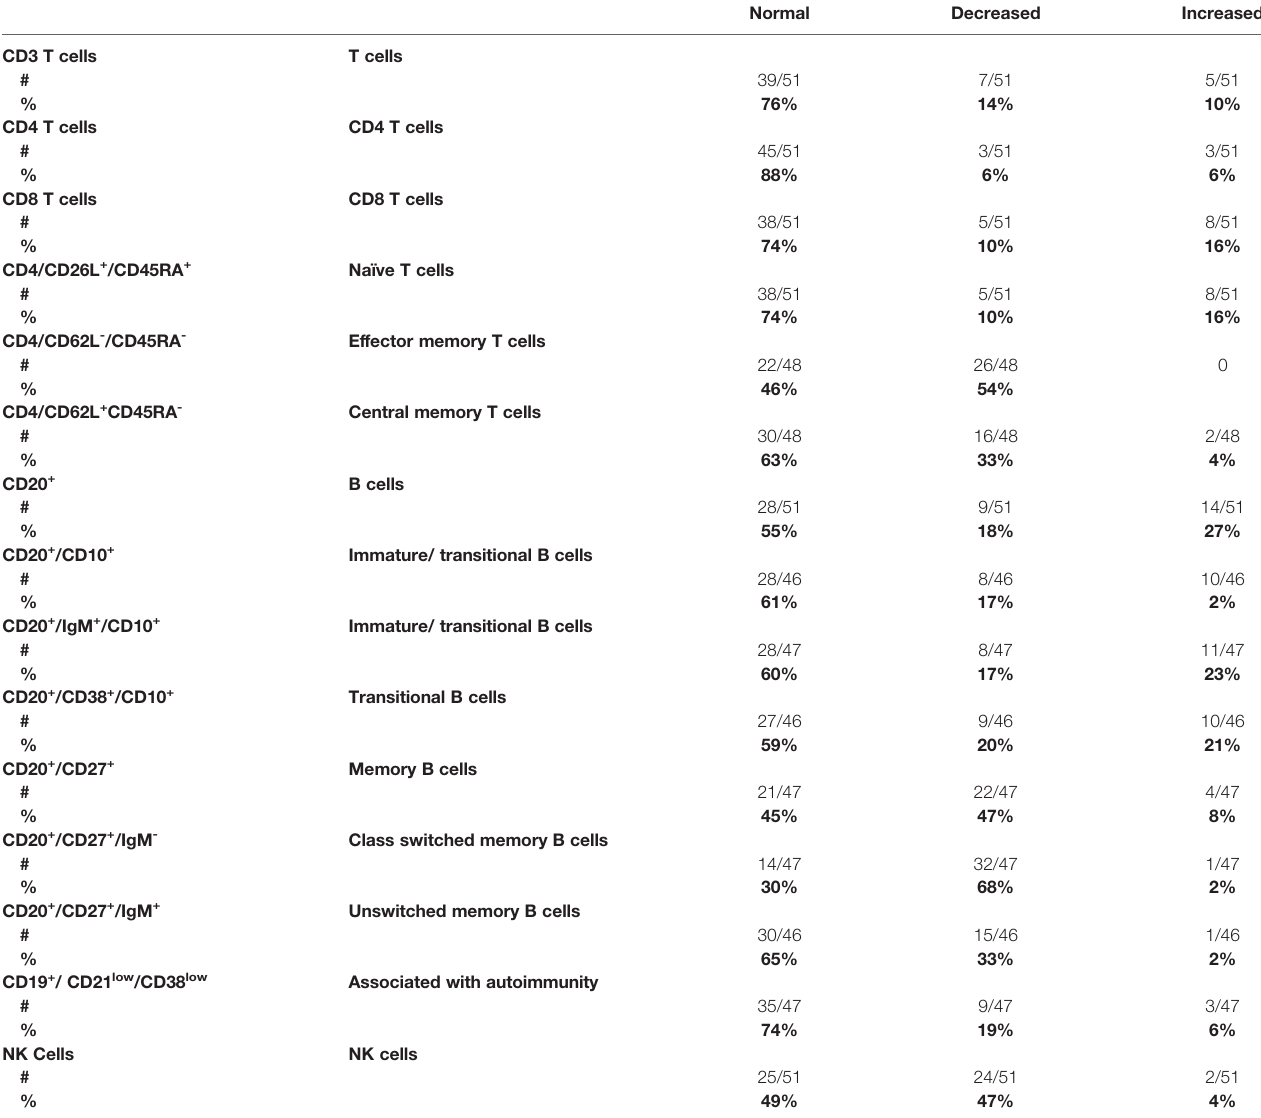
Normal Decreased Increased